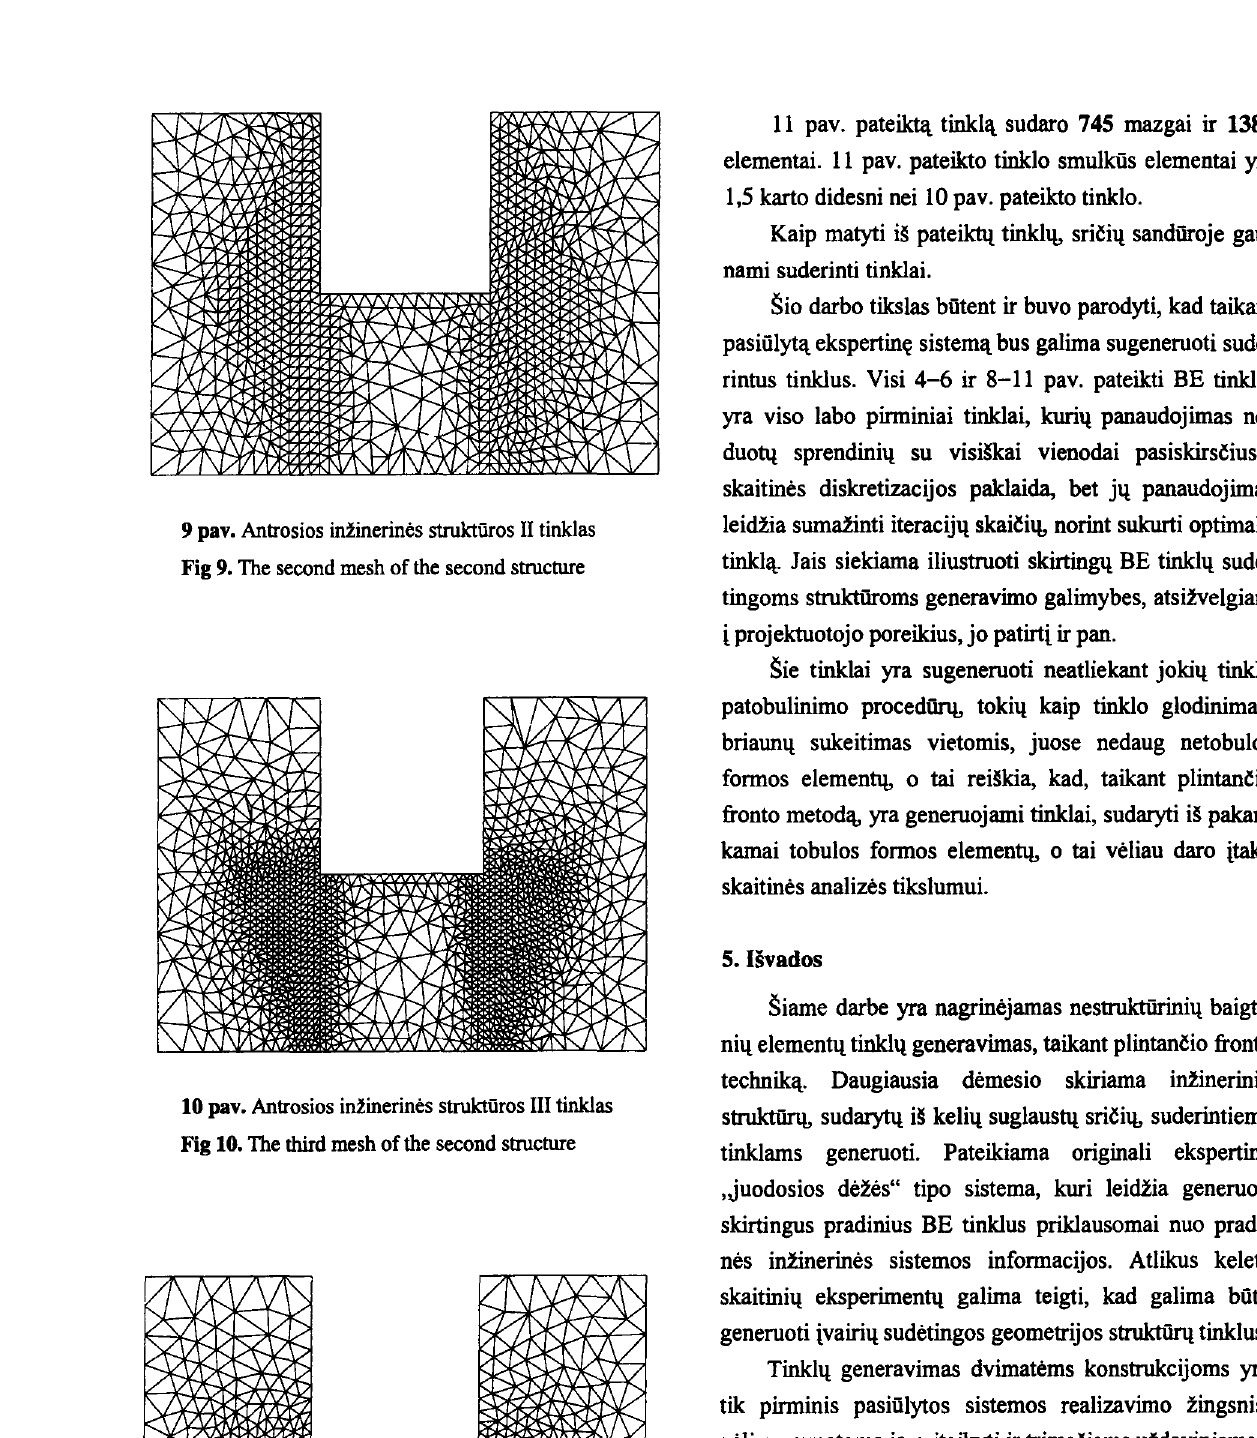
10 pav. Antrosios in!inerines struktiiros III tinklas Fig 10. The third mesh of the second structure